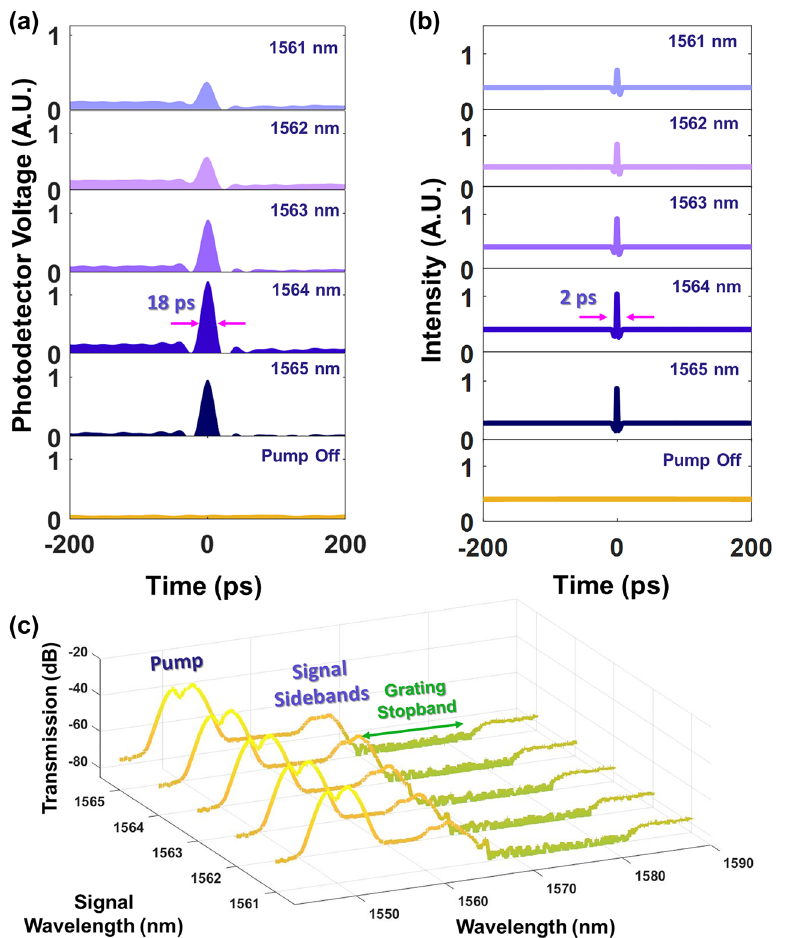
Figure3: Temporalcharacterizationofthesignal waveform as its wavelength is varied (Configuration1).Thepumpwavelengthisfixed at 1550 nm and the signal wavelength varied between 1561 – 1565 nm. The stopband of the grating used in this experiment is centered at 1575 nm. (a) Measured and (b) numerically calculated signal waveform as a function of signal wavelength. (c) Measured output spectrum from the nonlinear grating as a function of the signal wavelength, where the sidebands are seen to develop around the signal. The input signal is fi ltered from the spectrum to clearly show the XPM-induced sidebands that